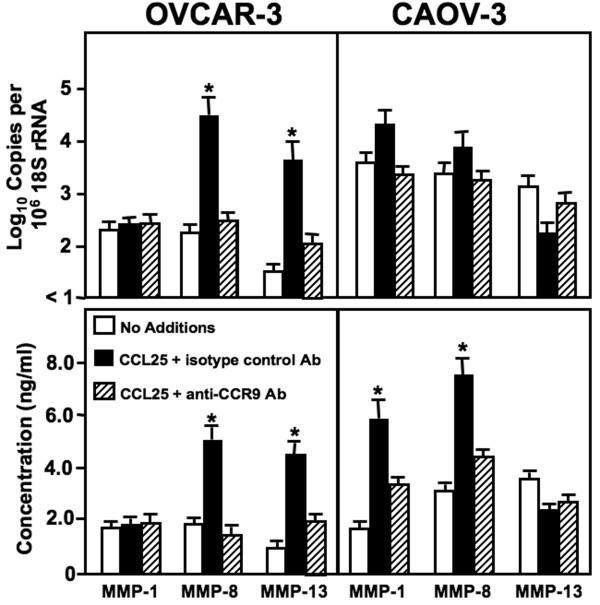
CCL25-induced collagenase expression by ovarian cancer cells. Cells were tested for their ability to express collagenases (MMP-1, MMP-8, and MMP-13) mRNA and protein. OVCAR-3 and CAOV-3 cells were cultured for 24 hours alone, with 100 ng/mL of CCL25, or CCL25 + 1 μg/mL of mouse anti-CCR9 antibody. Total RNA was isolated and quantitative RT-PCR analysis was performed for mRNA expression of collagenases (upper panel) and transcript copies are presented relative to actual copies of 18 S rRNA. Active collagenases were quantified by Fluorokine and Biotrak assays in conditioned media (lower panel). MMP expression below the detectable limit of the RT-PCR is designated as below detection (BD). Asterisk(s) indicate statistical differences (p < 0.01) between untreated and CCL25-treated OvCa cells.